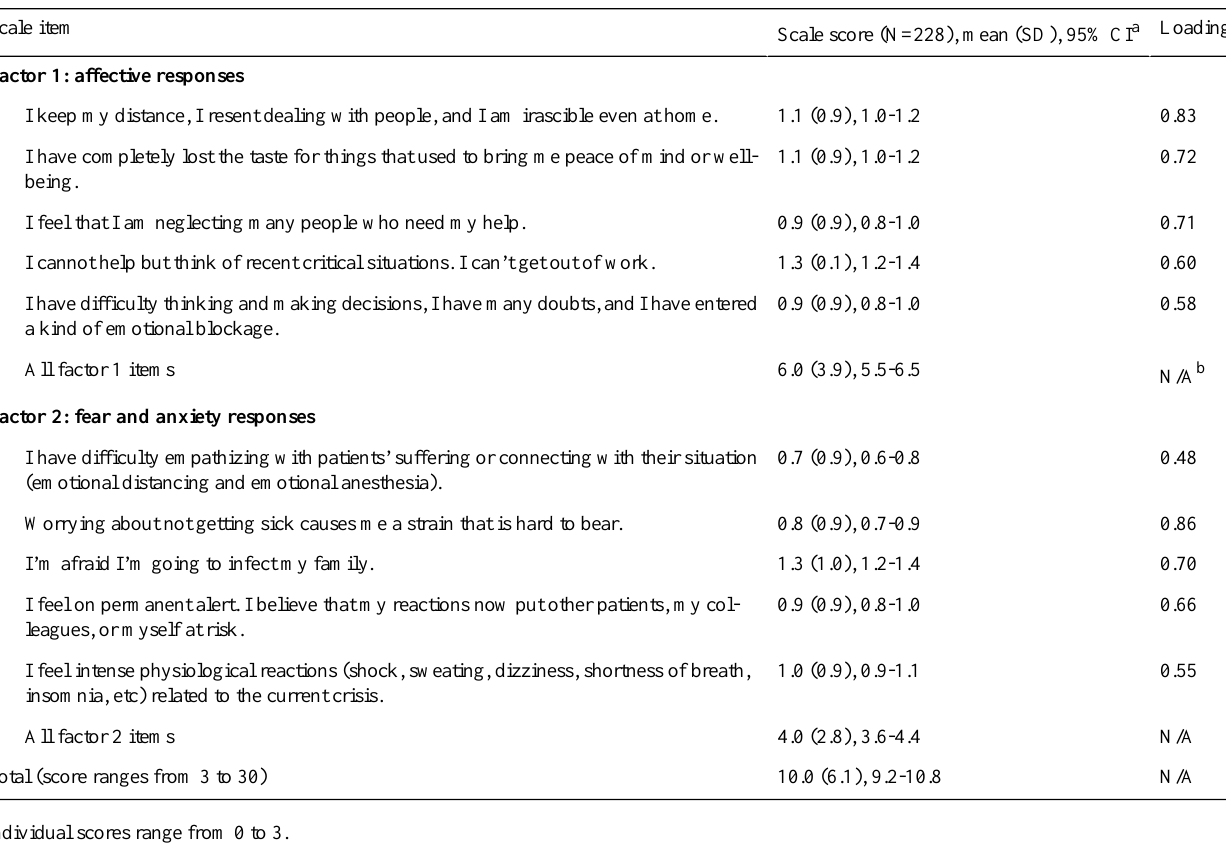
Table 2. Construct validity of the acute stress scale used among professionals caring for patients with